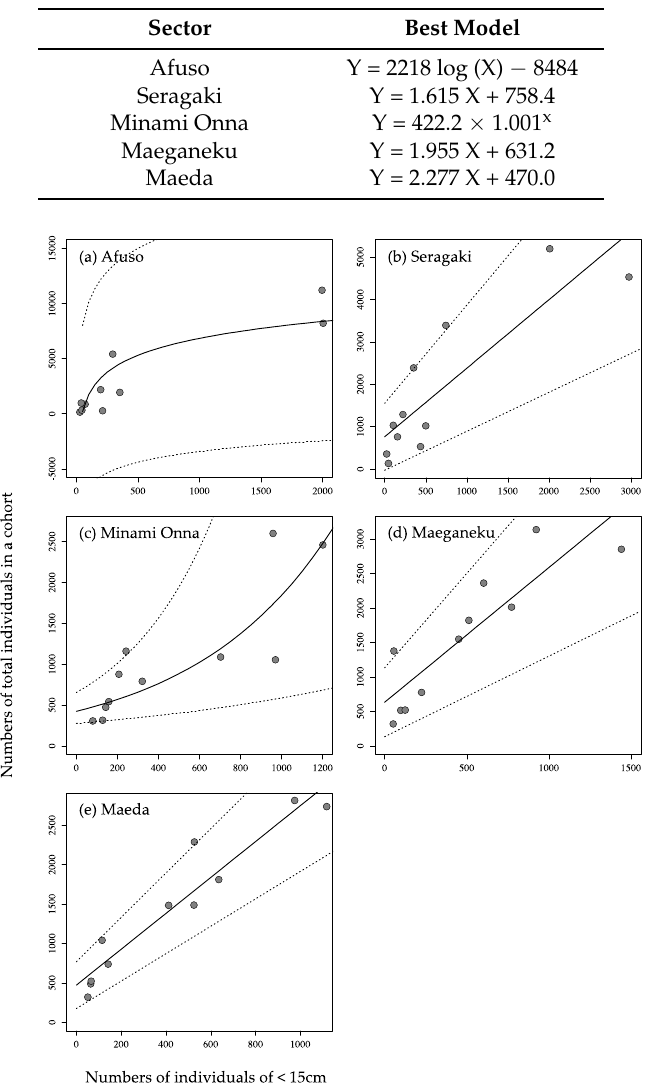
Table 4. Best model for all sectors along the Onna coast for predicting total removable cohort (Y) membership based upon the number of individuals <15 cm (X).